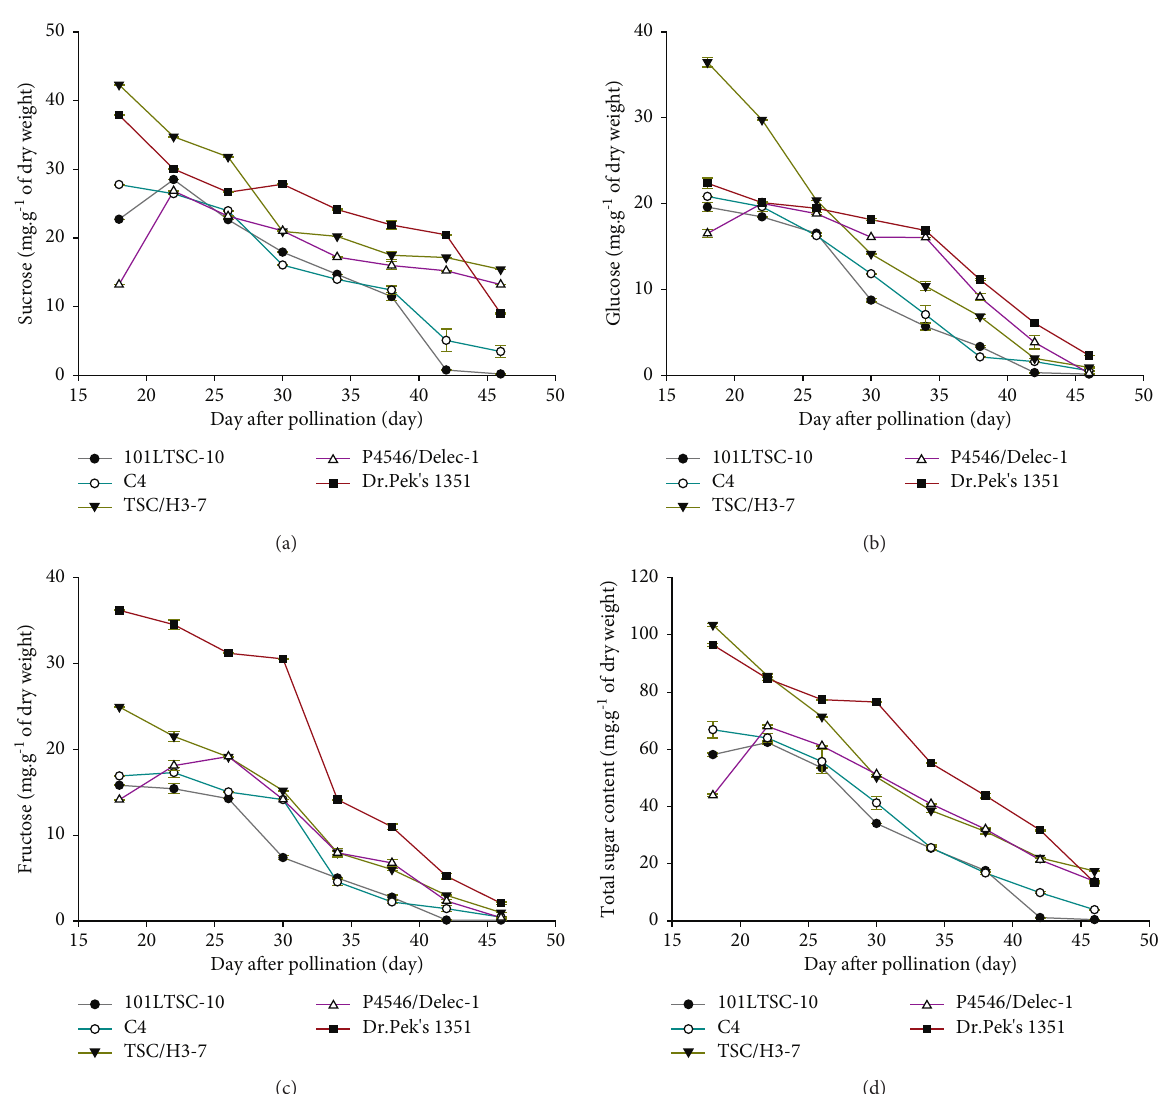
Figure 3: The changes of sugar contents during seed developments of sweet corn: (a) sucrose, (b) glucose, (c) fructose, and (d) total sugar content. The data are means of four replicate samples and error bar ± SD ( n �